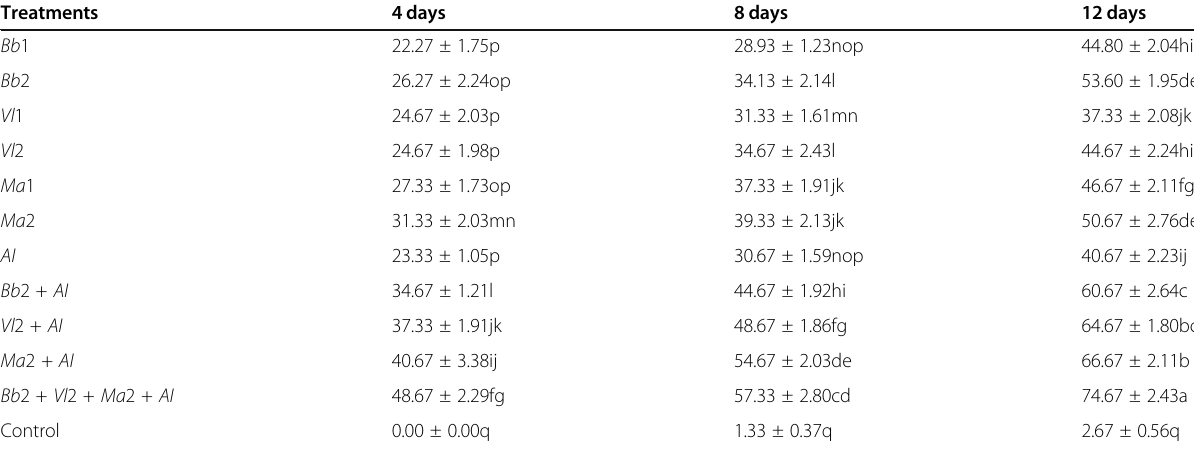
Table 1 Percent mortality (mean ± SE, n = 5) of 2 nd instar Pectinophora gossypiella larvae due to Beauveria bassiana , Verticillium lecanii , Metarhizium anisopliae concentrations and Azadirachta indica extract (alone and in combination) at different exposure intervals. Means sharing with same lower case letters are not significantly different from each other at 0.05 level of significance, i.e., P < 0.05